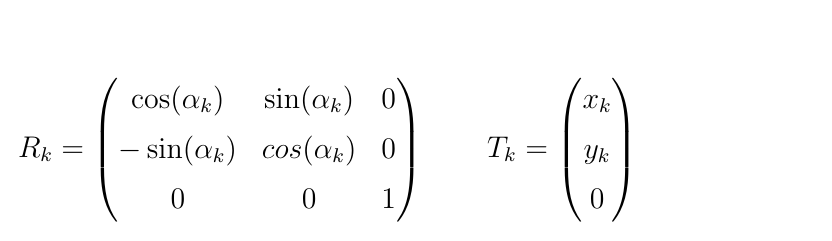
, robot’s coordinate W